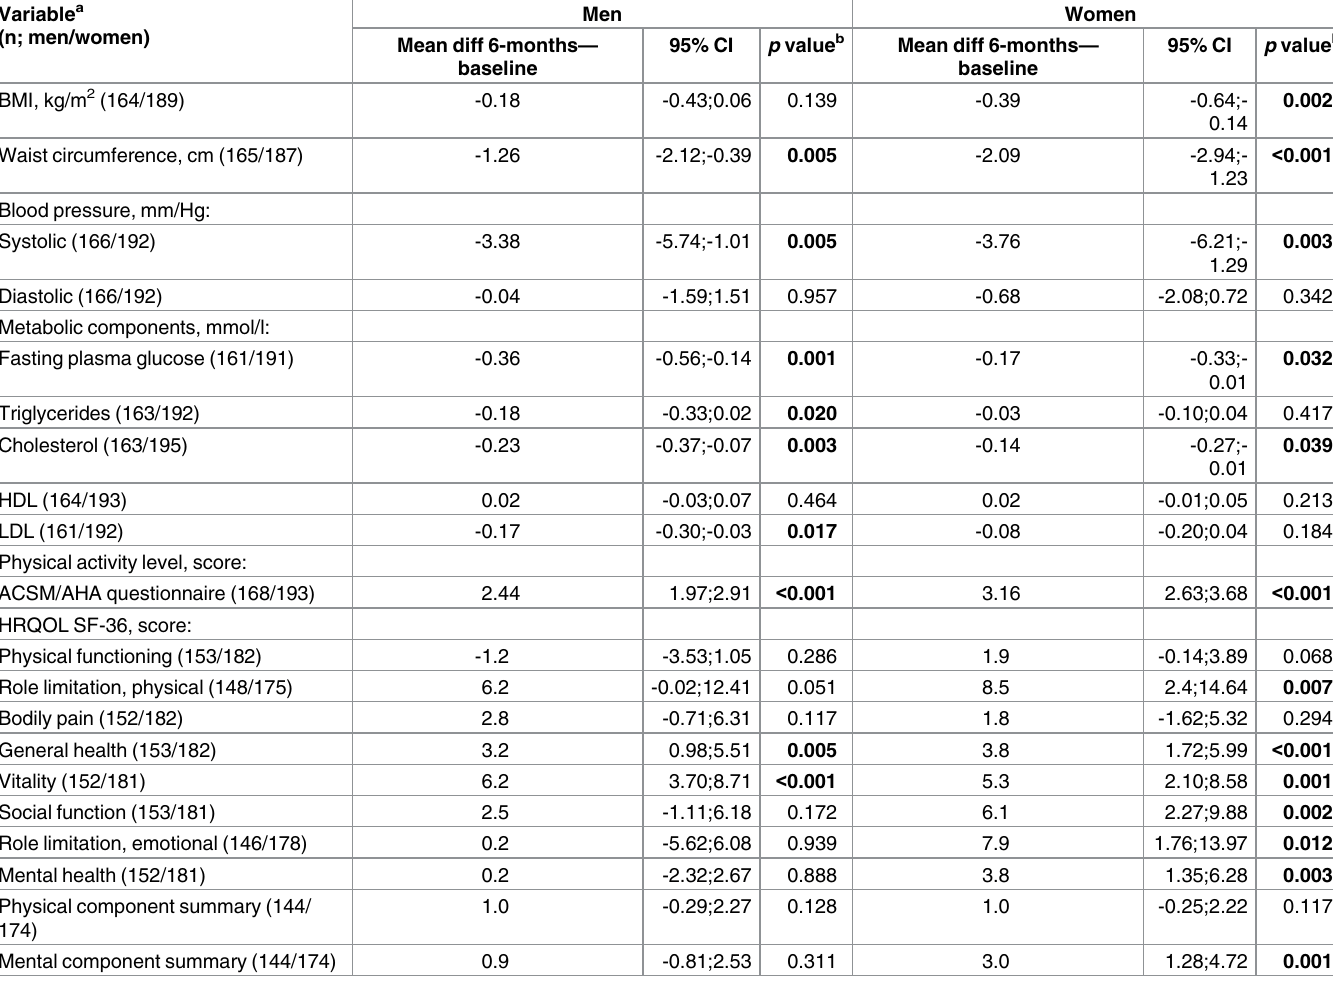
Table 8. Descriptivestatistics and differences for anthropometric-, metabolic characteristics, physical activity level and health related quality of life at baseline and 6-month follow-up—Men and women. Variable